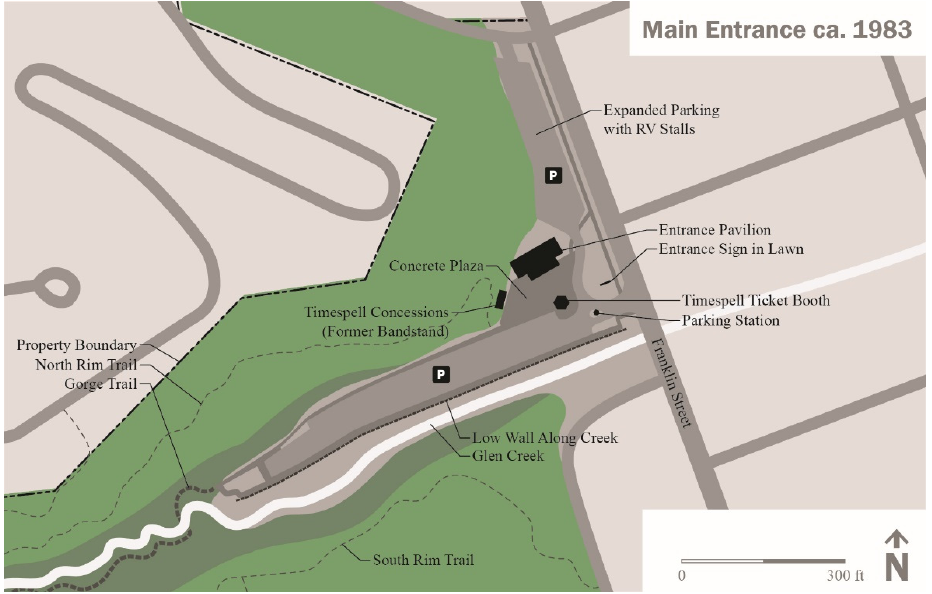
Figure 15. Plan of Main Entrance, ca. 1983, by author.